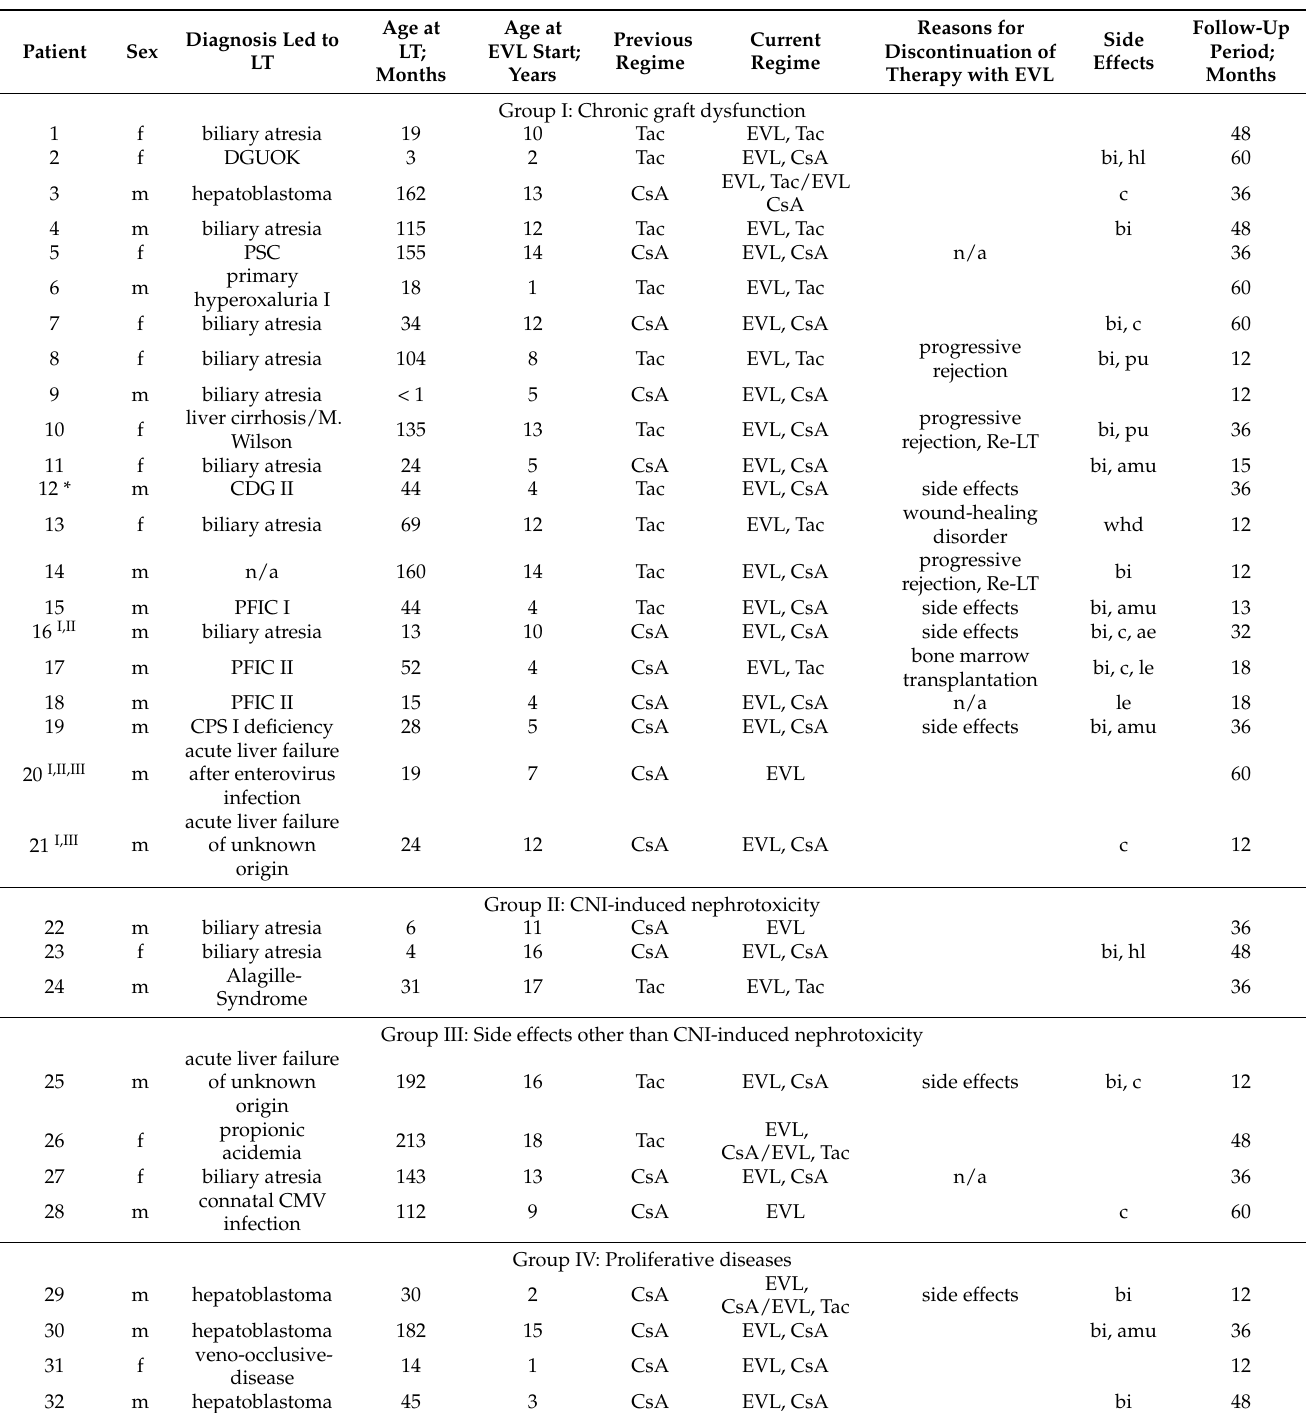
Table 1. Patient